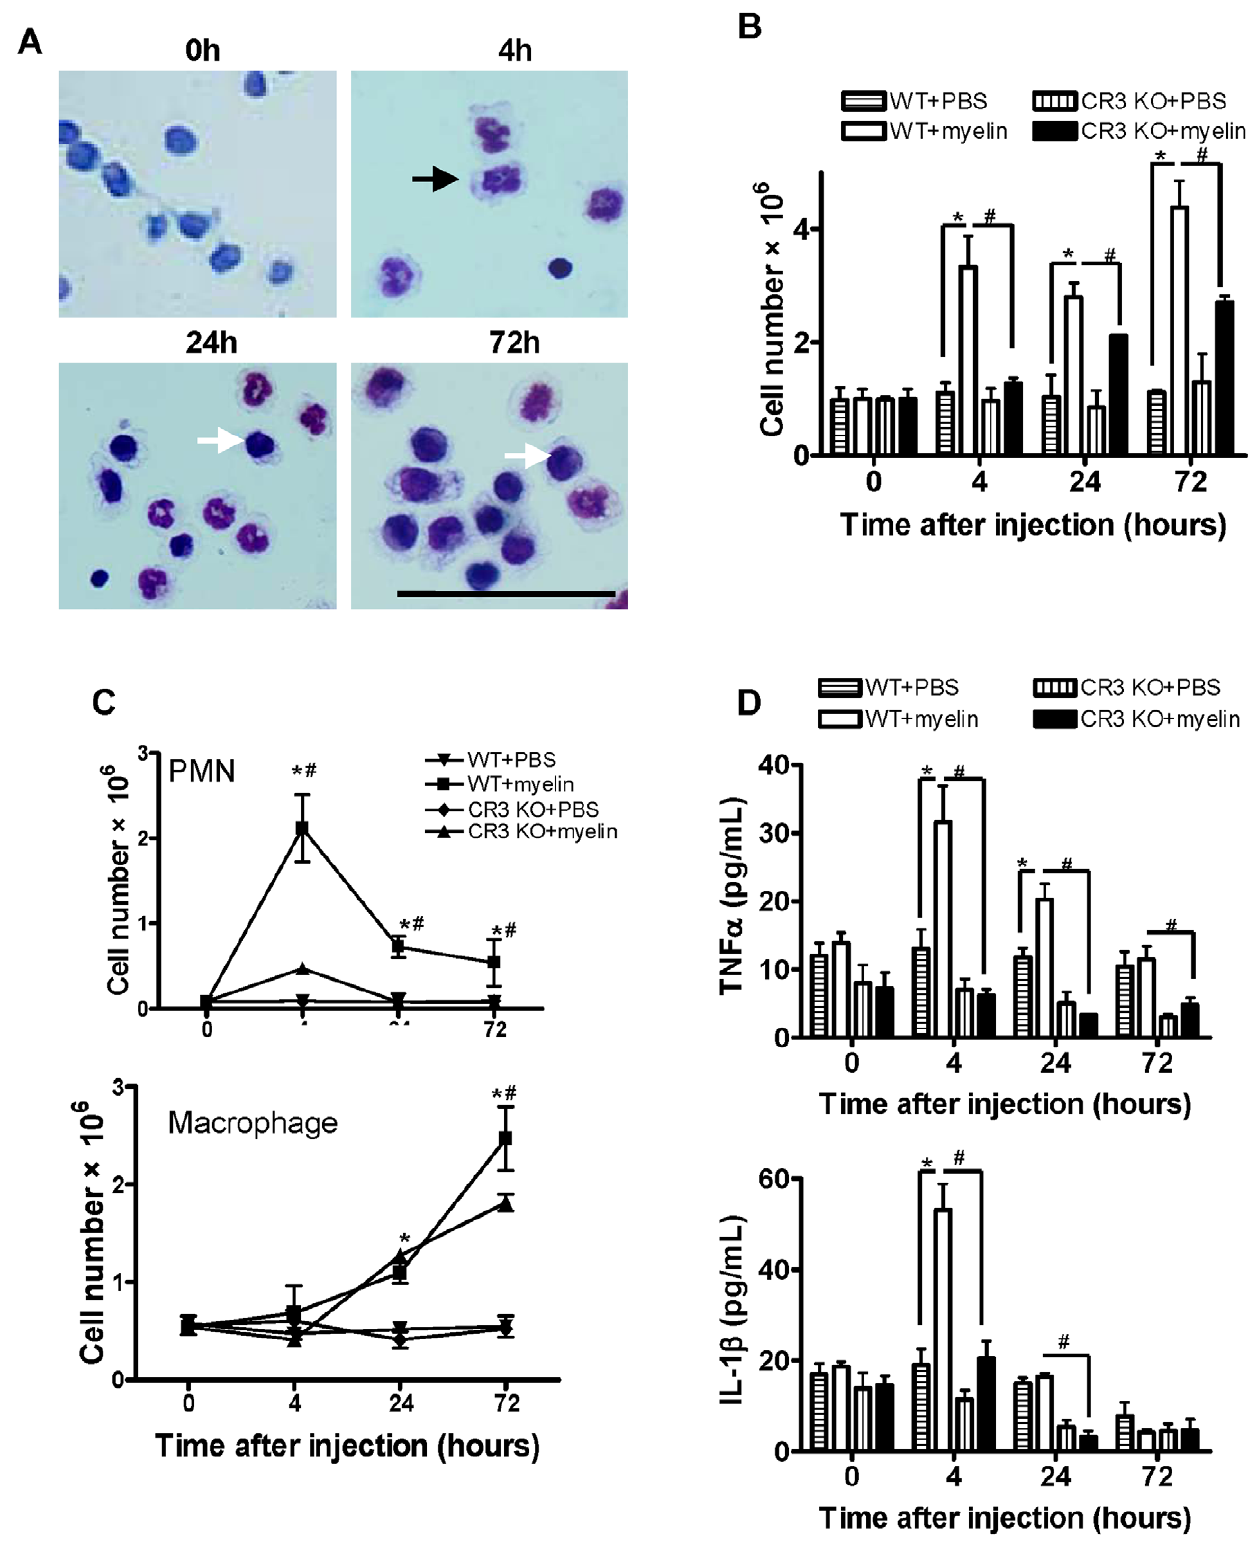
Figure 1. Inflammatory effect of myelin in peritoneal cavity from WT and CR3 KO mice. (A) Morphology of infiltrated cells in peritoneal cavity from WT mice. Neutrophils were indicated with black arrow and macrophages were indicated with white arrow. (Scale bar=50 m m). (B) The total number of cells in peritoneal cavity. (C) Number of infiltrated neutrophils and macrophages in peritoneal cavity. (D) Levels of TNF- a and IL-1 b in peritoneal lavage fluid detected by ELISA. Data were expressed as mean 6 SEM. (n=4 at each time point, *P , 0.05 vs. WT + PBS; # P , 0.05 vs. CR3 KO + Myelin; t -test).